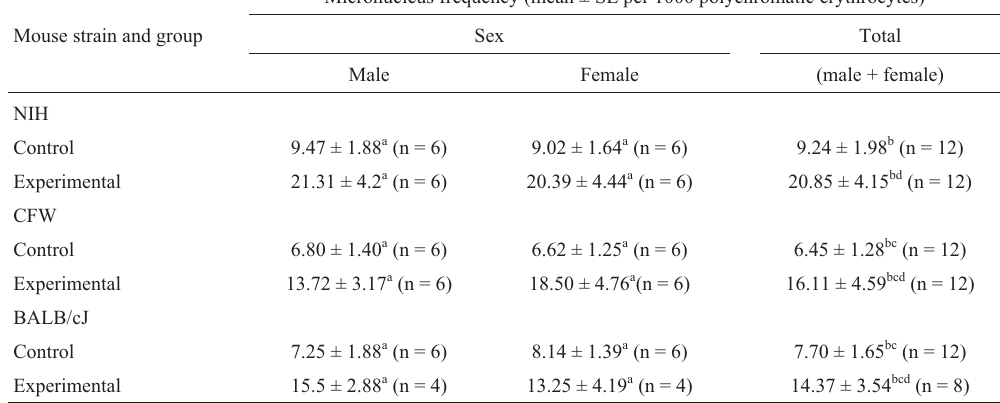
a Frequency values with this superscript did not differ significantly between male and female mice in the same row (p > 0.05). b NIH frequency values with this superscript differ significantly between rows (CFW and BALB/cJ) (p < 0.05). c CFW frequency values with this superscript did not differ significantly between rows (from BALB/cJ strain) (p > 0.05). d Frequency values with this superscript differ significantly from the control group for the same strain (p <